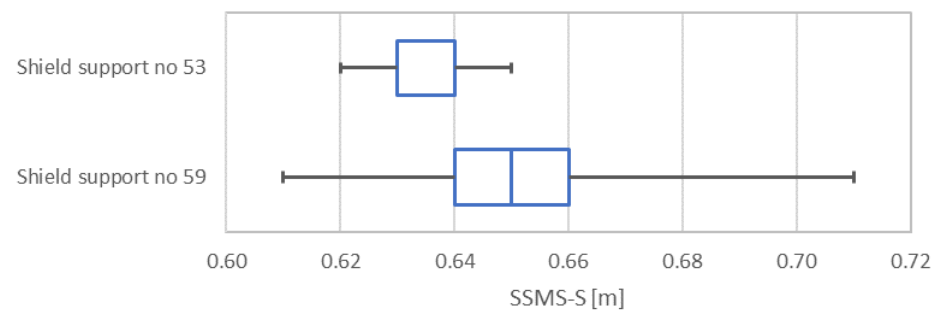
Figure 14. Box-and-whisker plot (scatter and shape of analysed data): tip-to face distance, shield support No. 53 and 59.